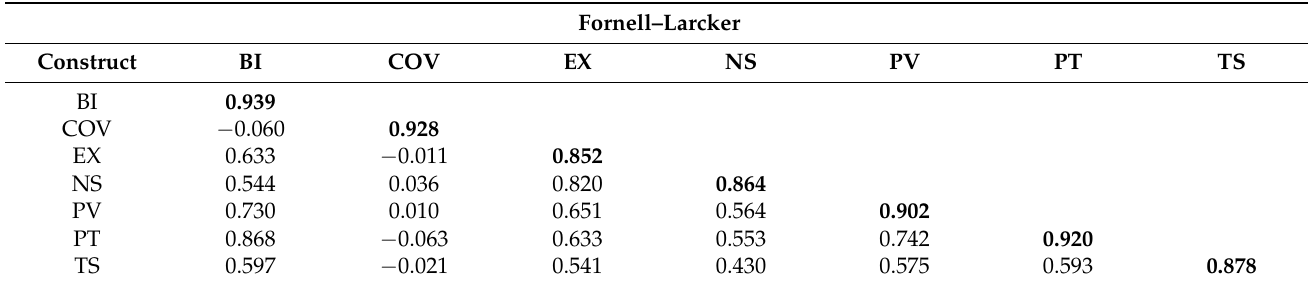
Table 2. Discriminant validity analyses (Fornell–Larcker).